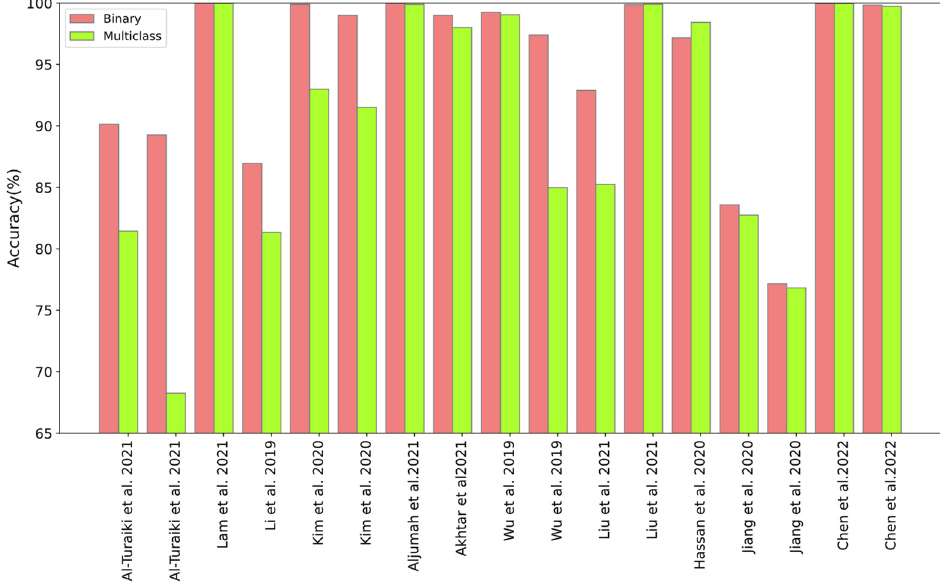
Figure 15. Comparison between binary and multiclass classification of the CNN-based IDS